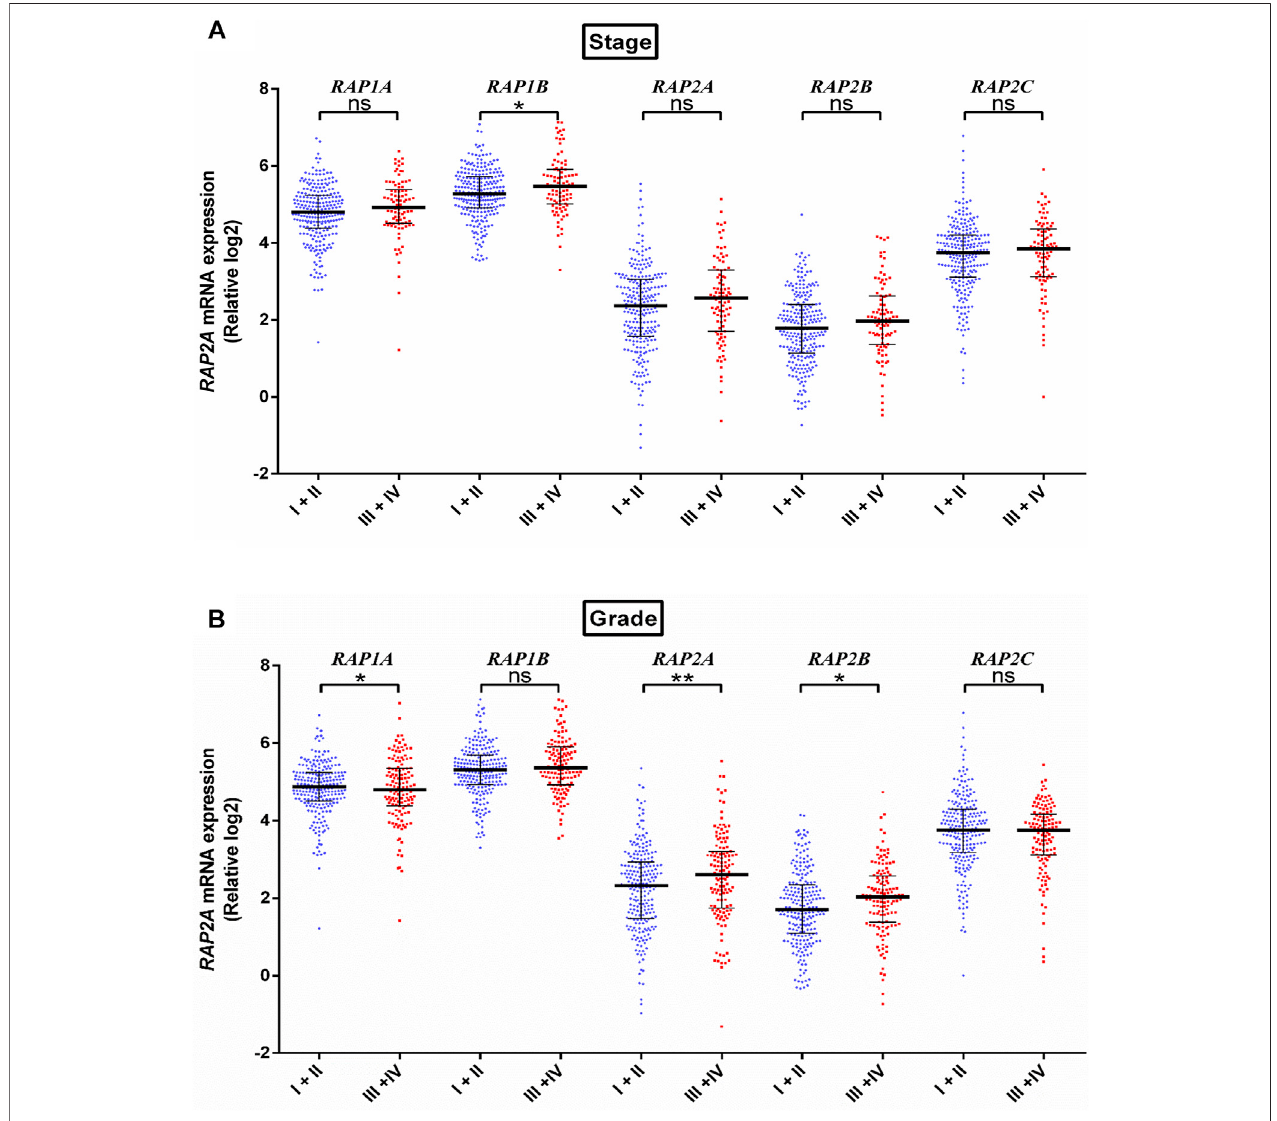
FIGURE3| ExpressionofRAPgenesintumor tissues comparedbetweendifferentstage (A) and grade (B) .**** p < 0.0001;*** p < 0.001;** p < 0.01;* p < 0.05;ns, p > 0.05.